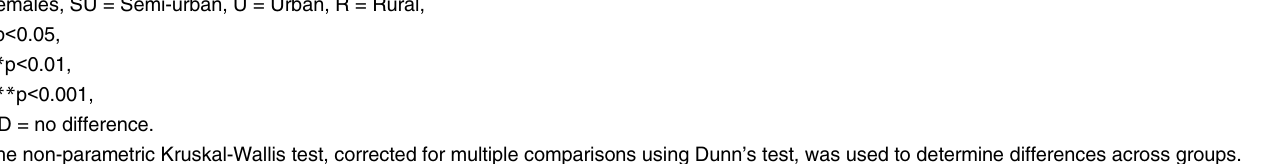
of 11 versus 9%) and absolute counts ([median of 258x10 3 versus 184x10 3 cells/ μ l], Table 4, all p < 0.05) compared to urban female vaccine study participants. Taken together, these data reveal significant differences in female lymphocyte subset distribution across cohorts with varying levels of urbanicity.